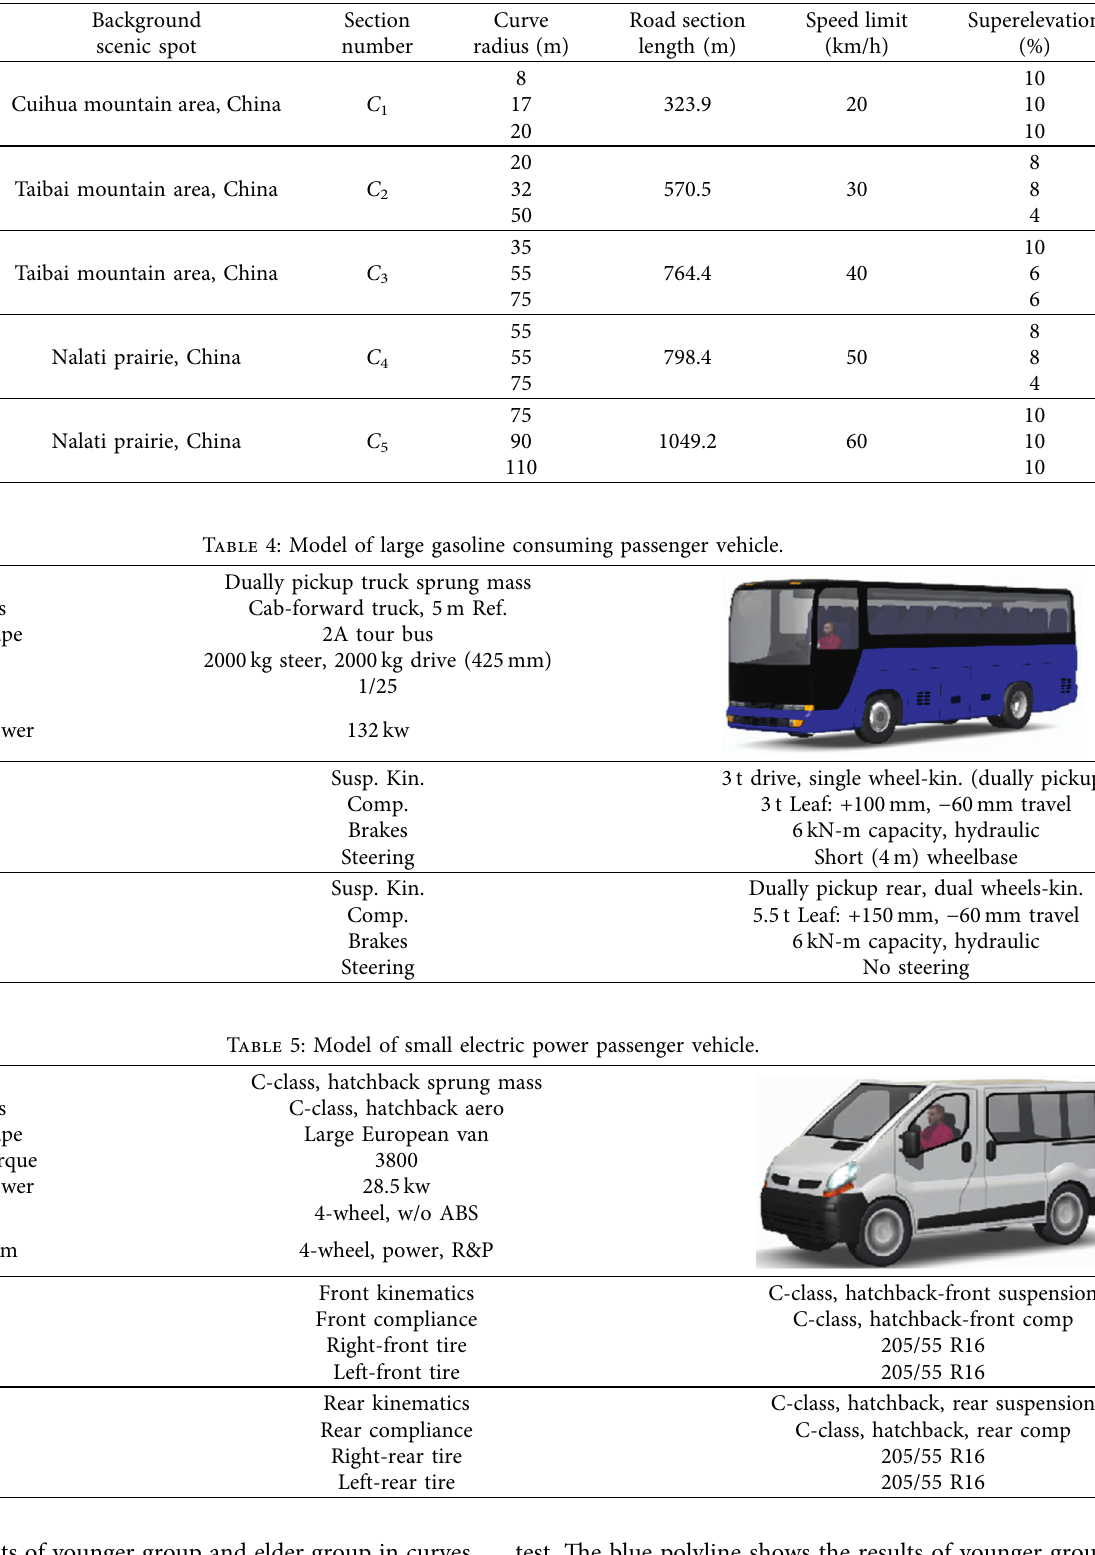
Table 3: Basic information of background road